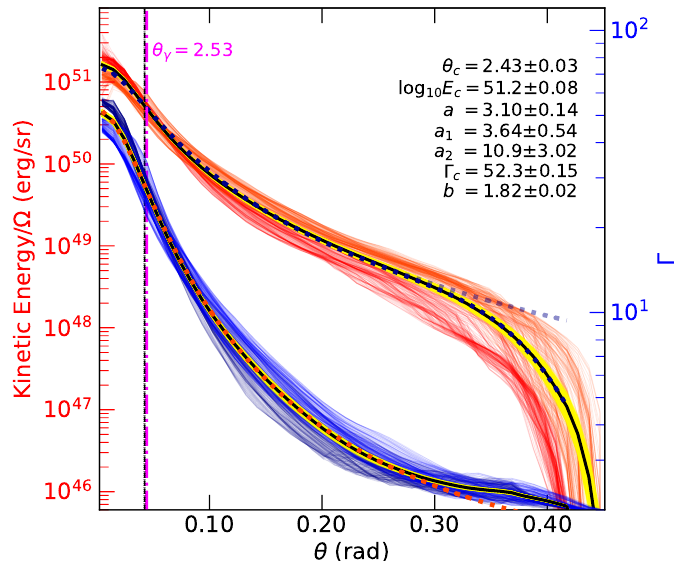
Figure 5. The energy (left axis) and Γ (right axis) profiles at each rotation step in φ for both the th50 (red/dark-blue) and gs50 (orange/blue). By assuming that the differences in these model profiles are the result of chaotic mixing processes while the jet propagates through the neutron star merger ejecta, we use a bootstrap to find the average profile (yellow are individual bootstrap means, black gives the distribution mean). We then fit our analytic jet structure profile for 0.0 ≤ θ ≤ 0.42rad to the distribution mean—the analytic model fit parameters are shown in the figure, and the profiles are indicated with a dotted line for both the energy and Γ